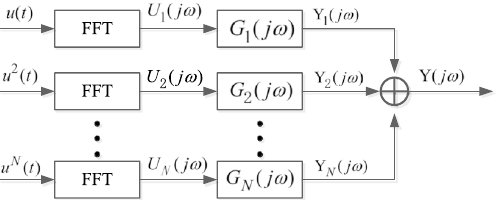
Figure 1. Output frequency response of nonlinear systems based on NOFRF.